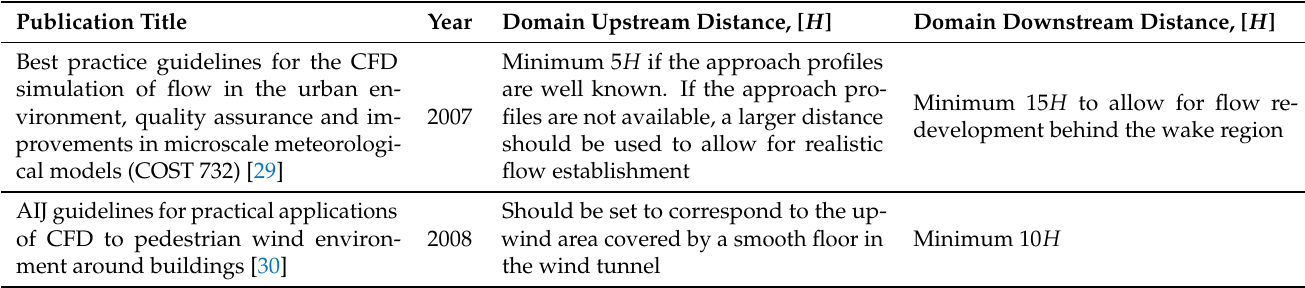
Table 4. Best practice guidelines on domain upstream and downstream distances.